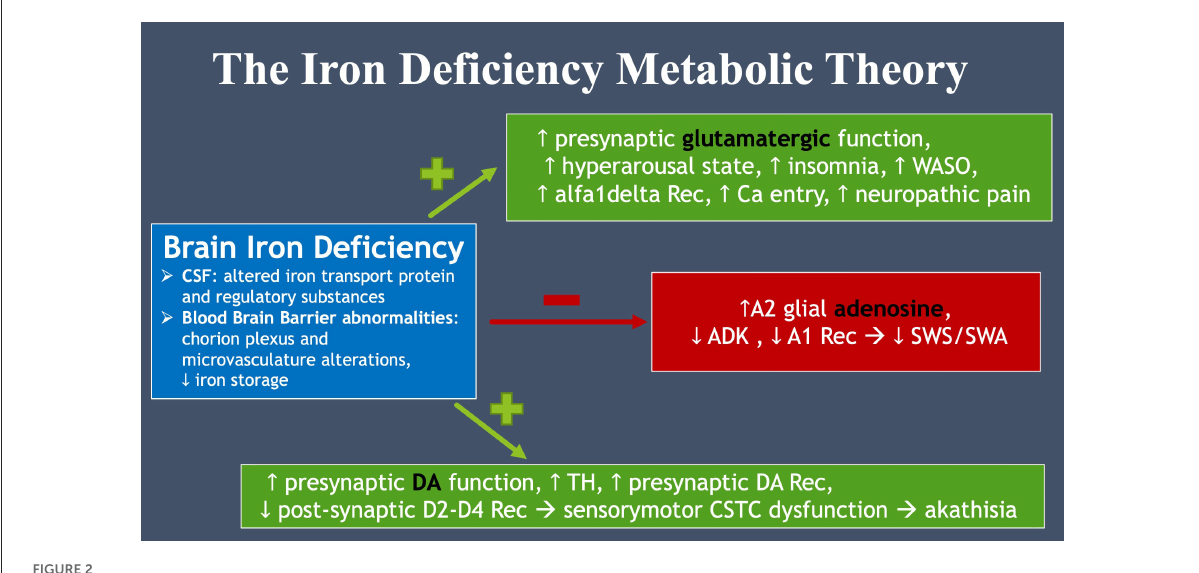
FIGURE2 The iron deficiency metabolic theory. Brain iron deficiency leads to glutamate, dopamine and adenosine dysfunction, all essential to RLS pathophysiology.